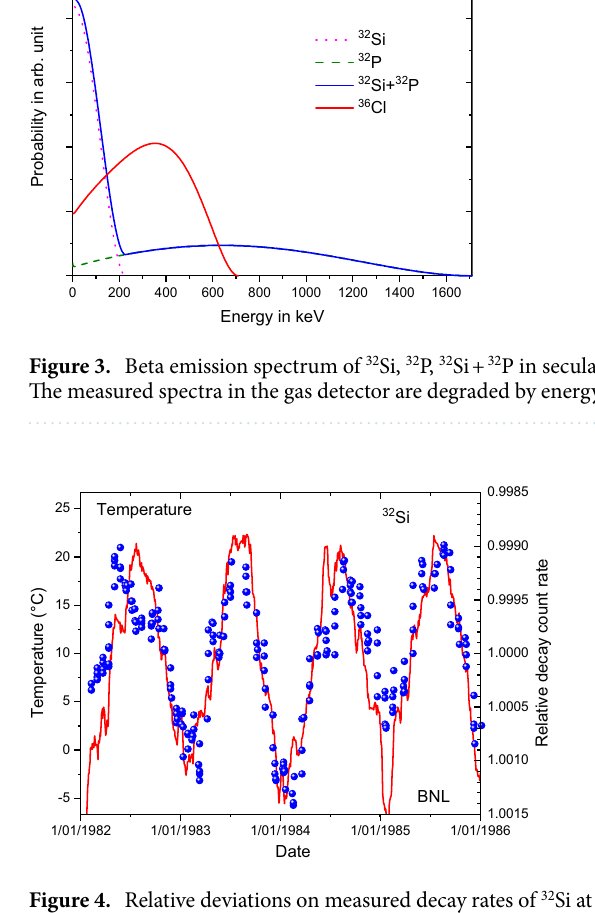
Figure 4. Relative deviations on measured decay rates of 32 Si at BNL (dots), compared to temperature data from a nearby weather station